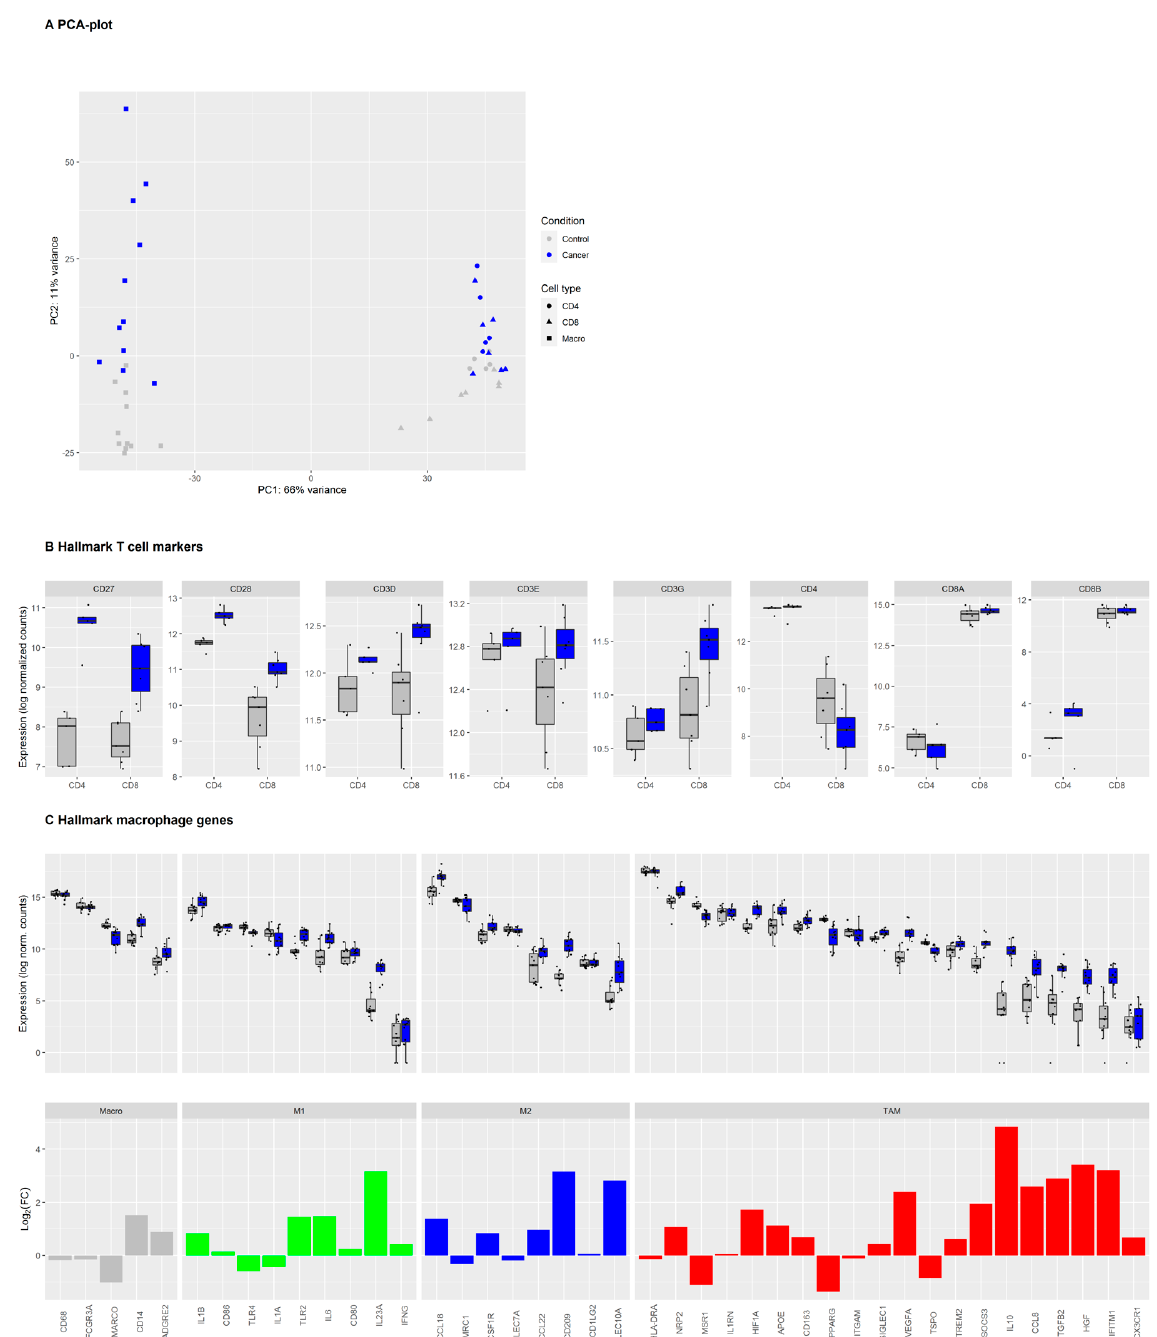
Figure 1. Expression of hallmark T cell and macrophage markers in tumor and normal lung immune cells in non-small-cell lung carcinoma (NSCLC). Legend: ( A ) Principal component analysis (PCA) of the log2-transformed, normalized gene expression count data of macrophages, CD4 + and CD8 + T cells originating from tumor (blue symbols) or adjacent healthy tissues (grey symbols). ( B ) Gene expression levels for individual samples of hallmark markers of CD4 + and CD8 + T cells in sorted CD4 + ( n = 5) and CD8 + ( n = 7) T cells from healthy tissue (grey) or tumor (blue). Boxes and whiskers display the inter-quartile range and the upper and lower limits of 1.5 x the inter-quartile range. Data beyond the end of the whiskers are outliers and plotted as points. ( C ) Upper panel: Macrophage hallmark marker gene expression in macrophages ( n = 11) from healthy tissue (grey) or tumor (blue). Genes were grouped into general macrophage markers, canonical M1 and M2 markers, and tumor-associated macrophages (TAM) markers. Lower panel: Barplot of log2-fold change in differential gene expression levels in TAMs versus non-tumor